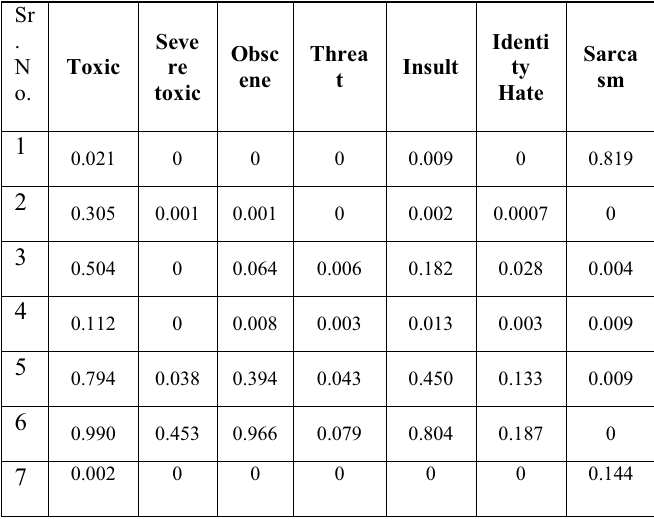
Table 2. Shaming type detection using CNN model. Sr.No.